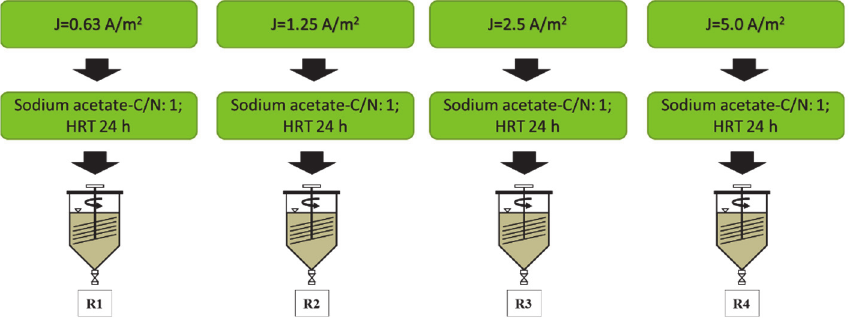
Figure 1. Experimental design .